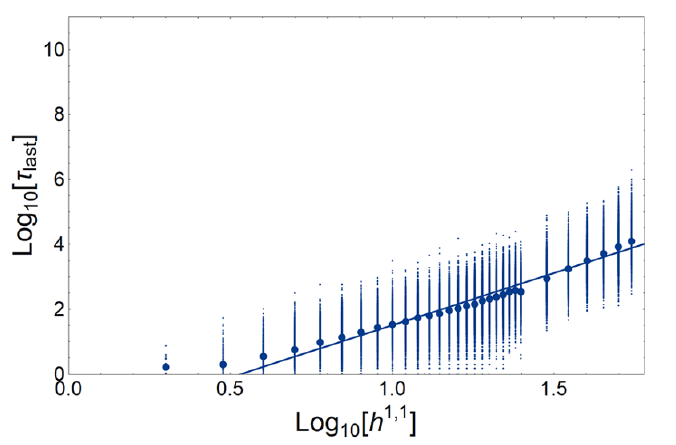
, de(cid:12)ned in (4.23), and (cid:28) \ last